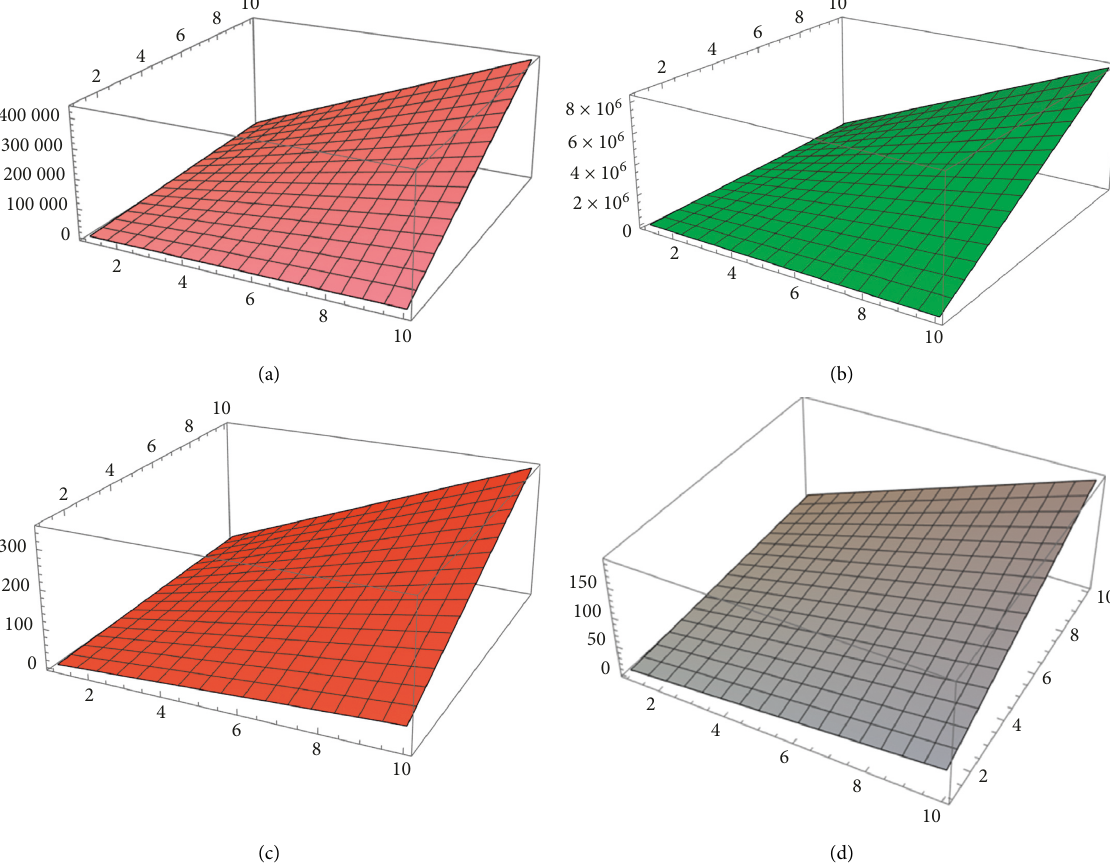
Figure 6: (a)HF 1 (SiC 4 – II [ r , s ]), (b) HF 2 (SiC 4 – II [ r , s ]), (c) Sum connectivity F-index SiC 4 – II [ r , s ], and (d) Product Connectivity F-index SiC 4 – II [ r , s